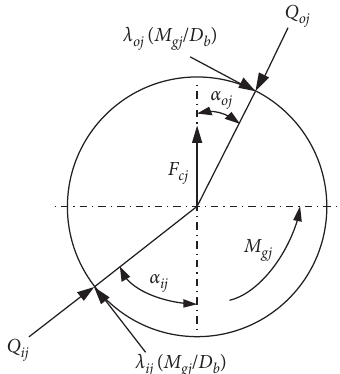
Figure 5: Loads on the j -th ball rolling